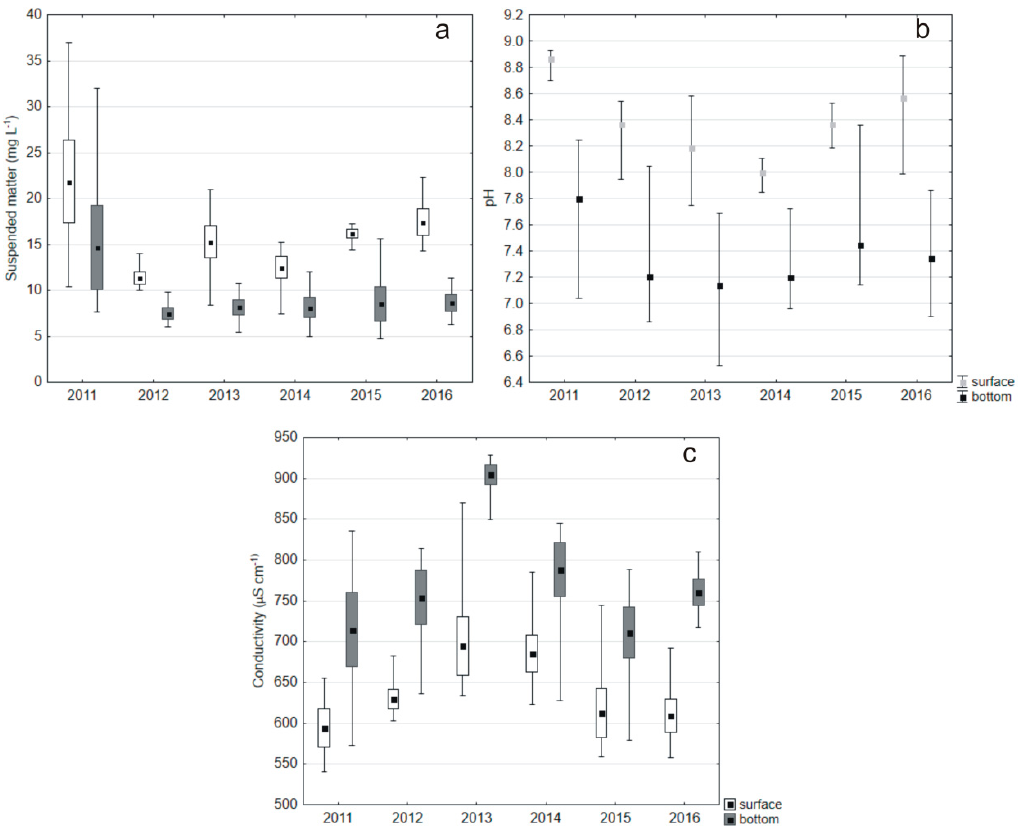
Figure 4. The mean content of total suspended solids ( a ), median pH ( b ), and mean conductivity ( c ), at the surface and above the bottom in Swarz ę dzkie Lake in the period April–September before